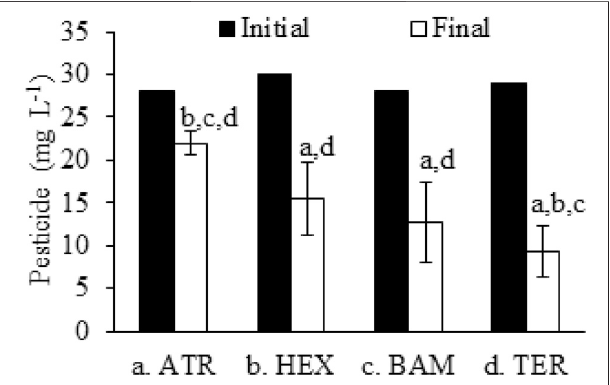
FIGURE 5 | Atrazine (ATR), hexazinone (HEX), 2,6-dichlorobenzamide (BAM), and terbutryn (TER) concentrations in 1.5% agar-solidi fi ed water after stabilization of concentrations (days 5 – 33). The error bars indicate standard deviations (n (cid:2) 15), and the letters next to the bars show statistically signi fi cant differences (Mann-Whitney ’ s